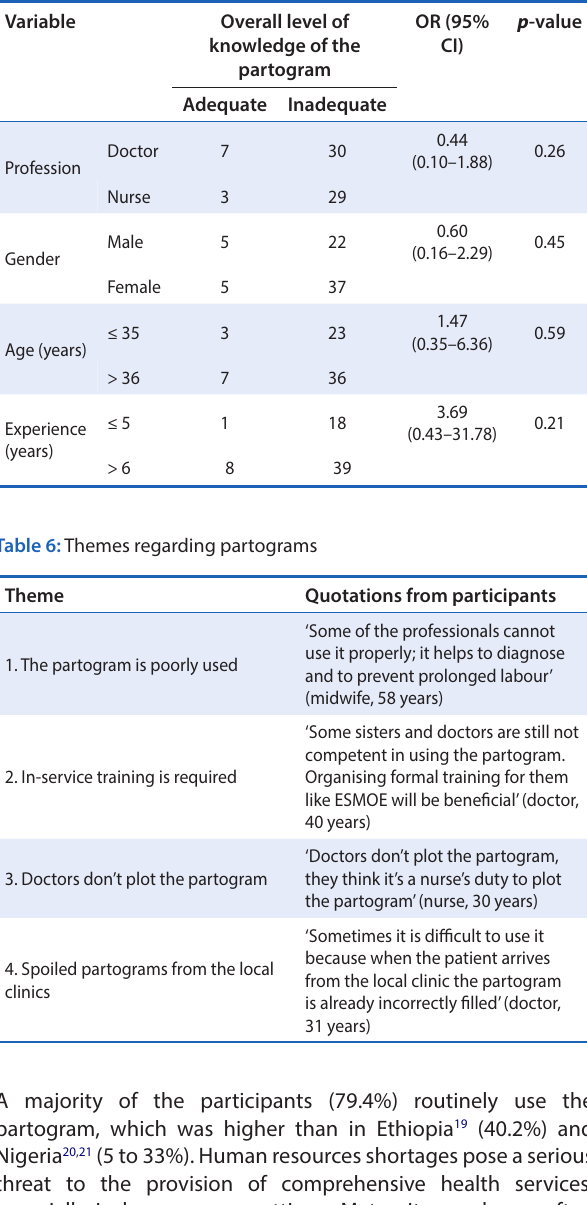
Table 5: Association of overall (summative) knowledge of partogram and demographic variables